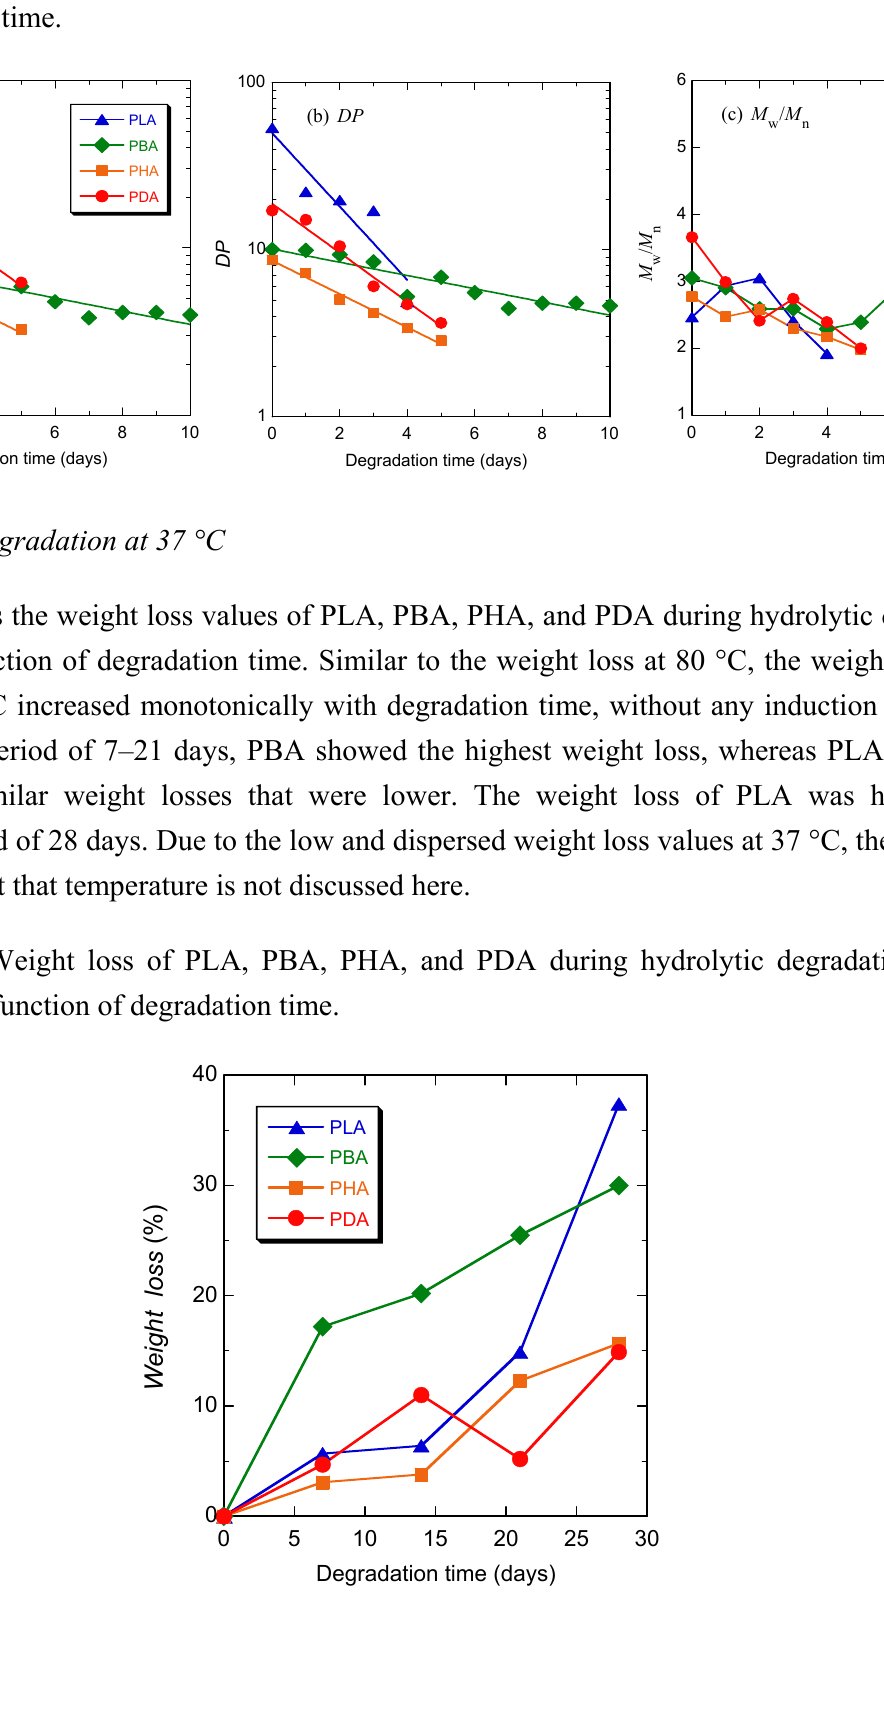
( b ), and molecular weight distribution ( M n